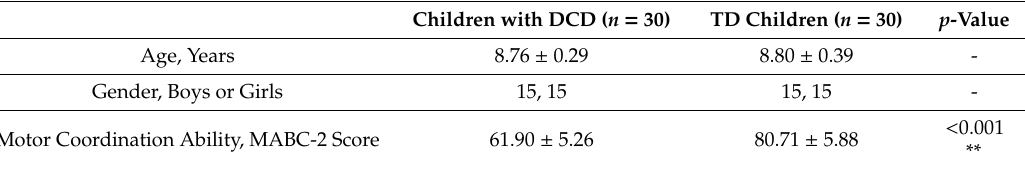
Table 1. General characteristics of